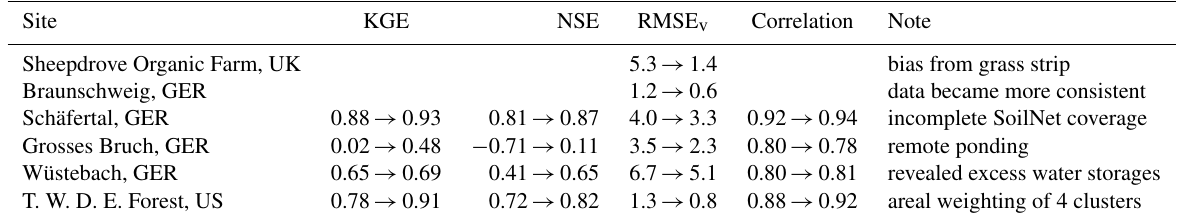
Table 2. Summary of the CRNS performances achieved by changing from the conventional to the revised weighting approach. RMSE v is in units of volumetric %. CRNS data have been calibrated on 3 sampling days (sites 1–2) or on time series of a soil moisture monitoring network (sites 3–6). The revised weighting approach improved the performance at all sites, and helped to identify additional hydrological